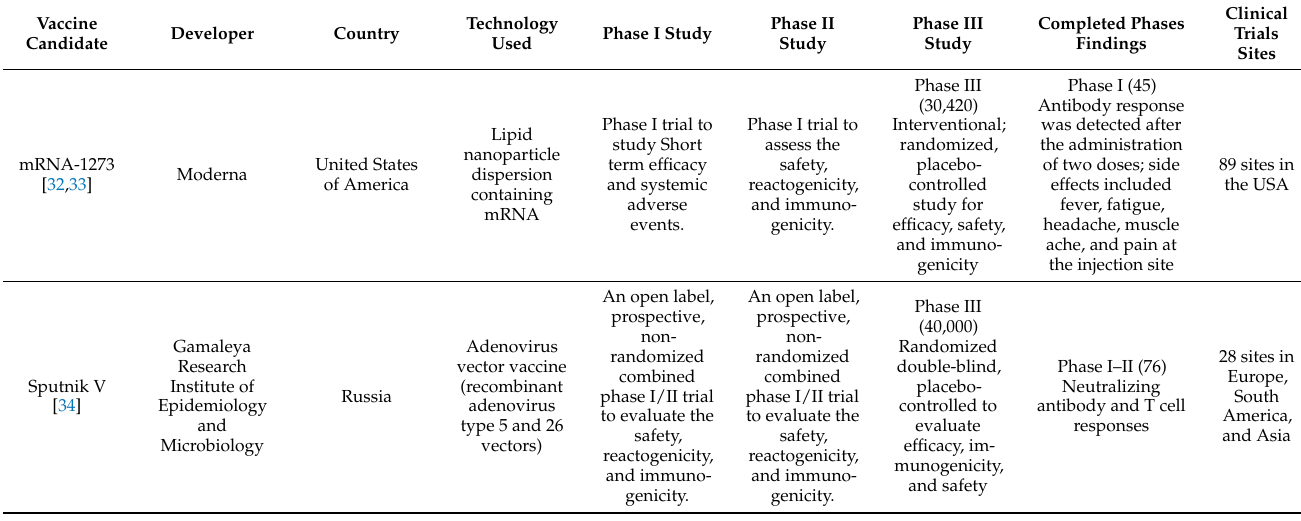
Table 1. Vaccines that went to phase